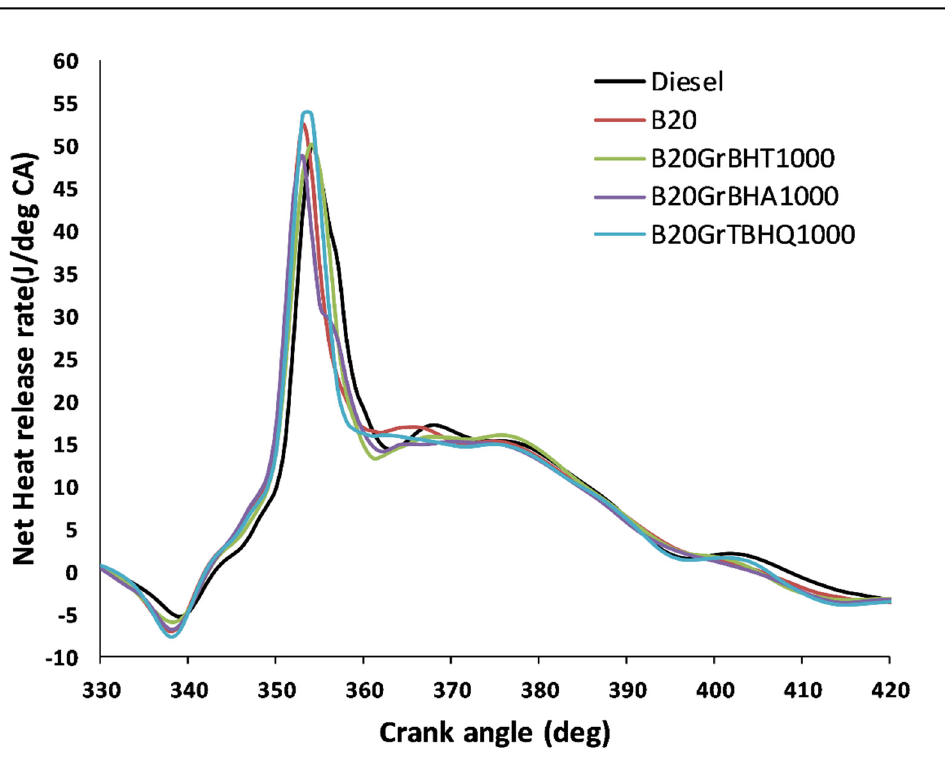
Figure 6. Deviation of heat release rate with crank angle. Energies 2021 , 14 , 4306